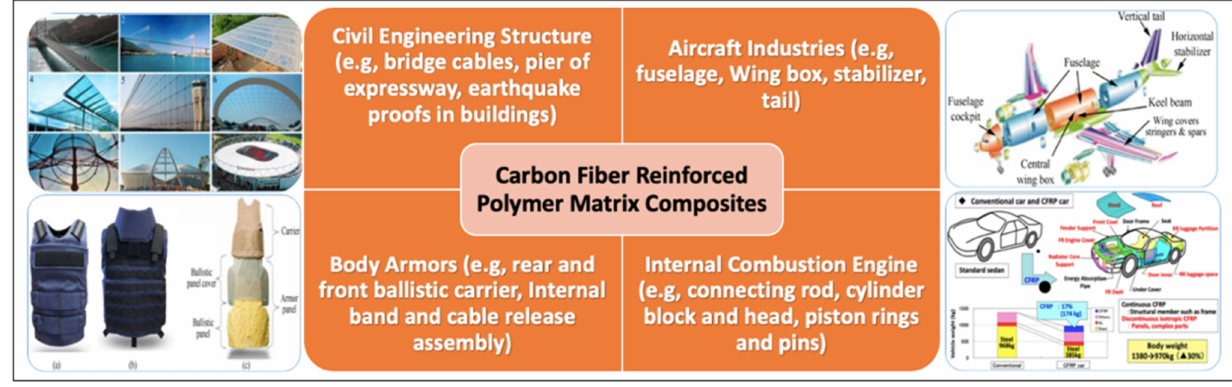
Figure 13. Applications of carbon fiber-reinforced polymer composites [86–89].